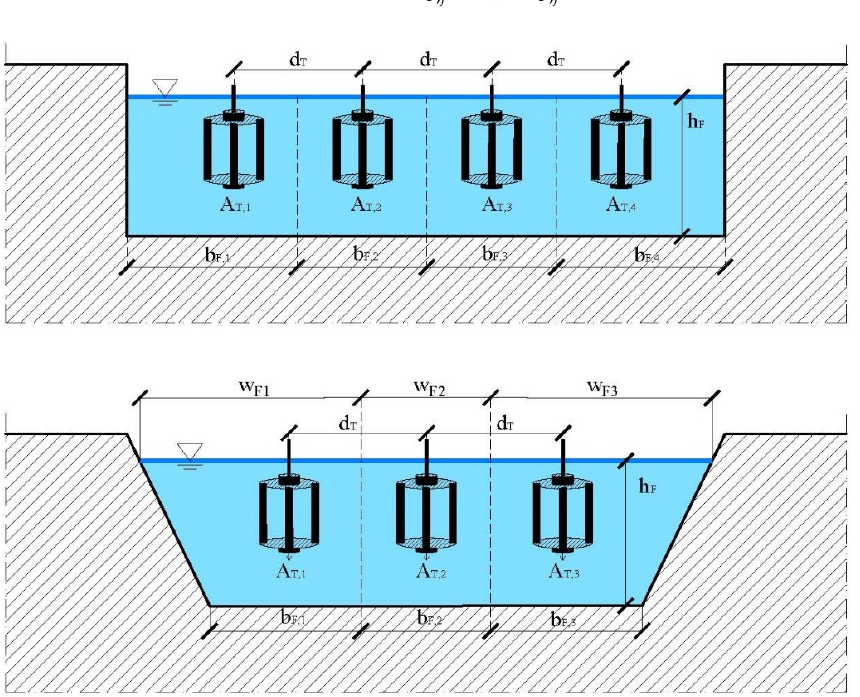
Figure 4. Flow passages determined for multiple HK turbines.